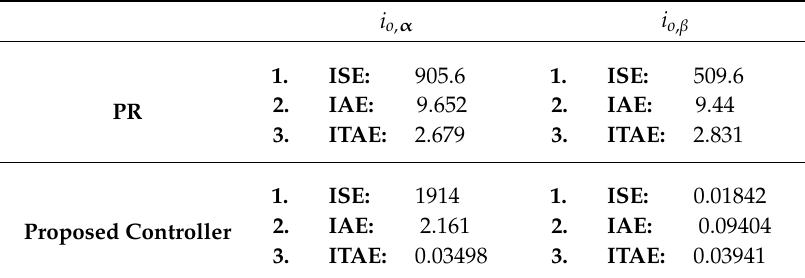
Table 1. Performance indices of output current controllers .